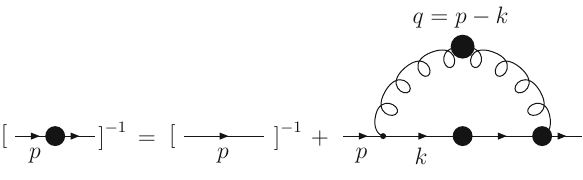
Fig. 2 The Dyson–Schwinger equation for the quark. The solid blobs denote dressed propagators and